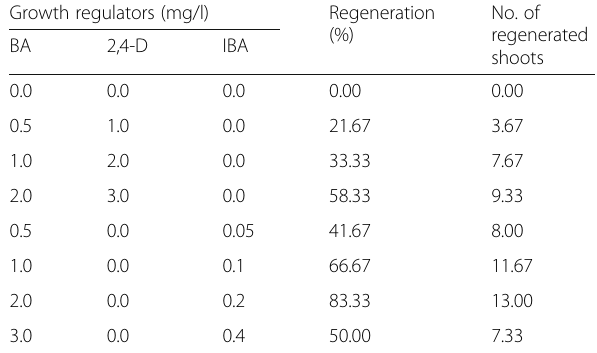
Table 2 Effect of different concentrations of BA and 2,4-D or IBA on shoots regeneration from leaf-derived callus of J. curcas after 6 weeks of cultivation Growth regulators